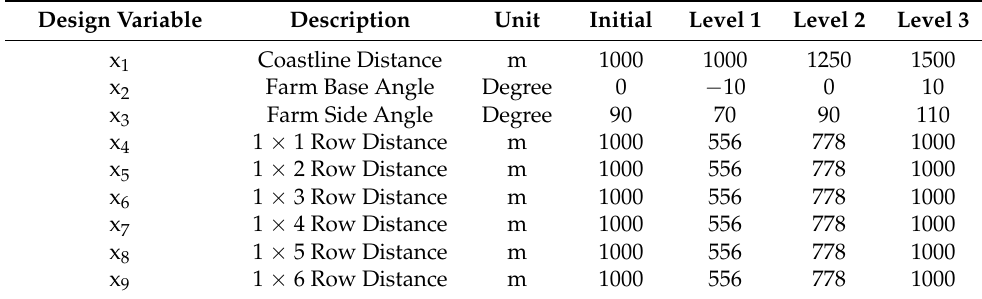
Table 2. Taguchi orthogonal array L54 matrix and results with respect to the nine design variables.